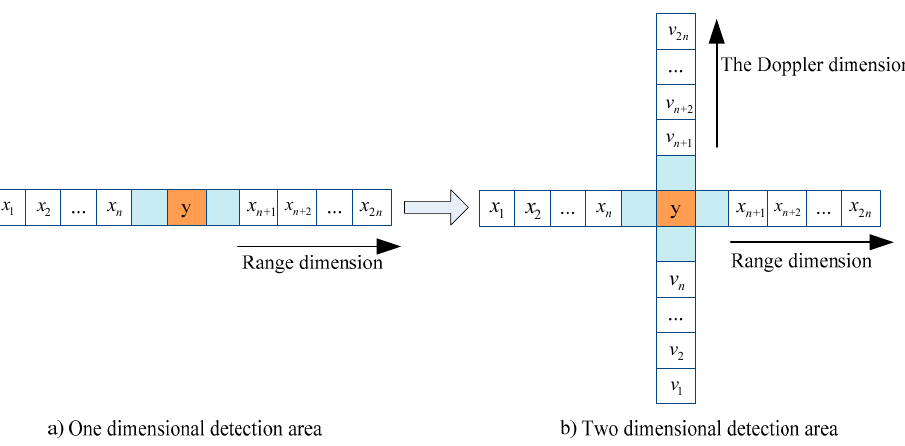
Figure 6. Schematic diagram of CFAR detection area, ( a ) One-dimensional detection area, ( b ) Two-dimensional detection area.